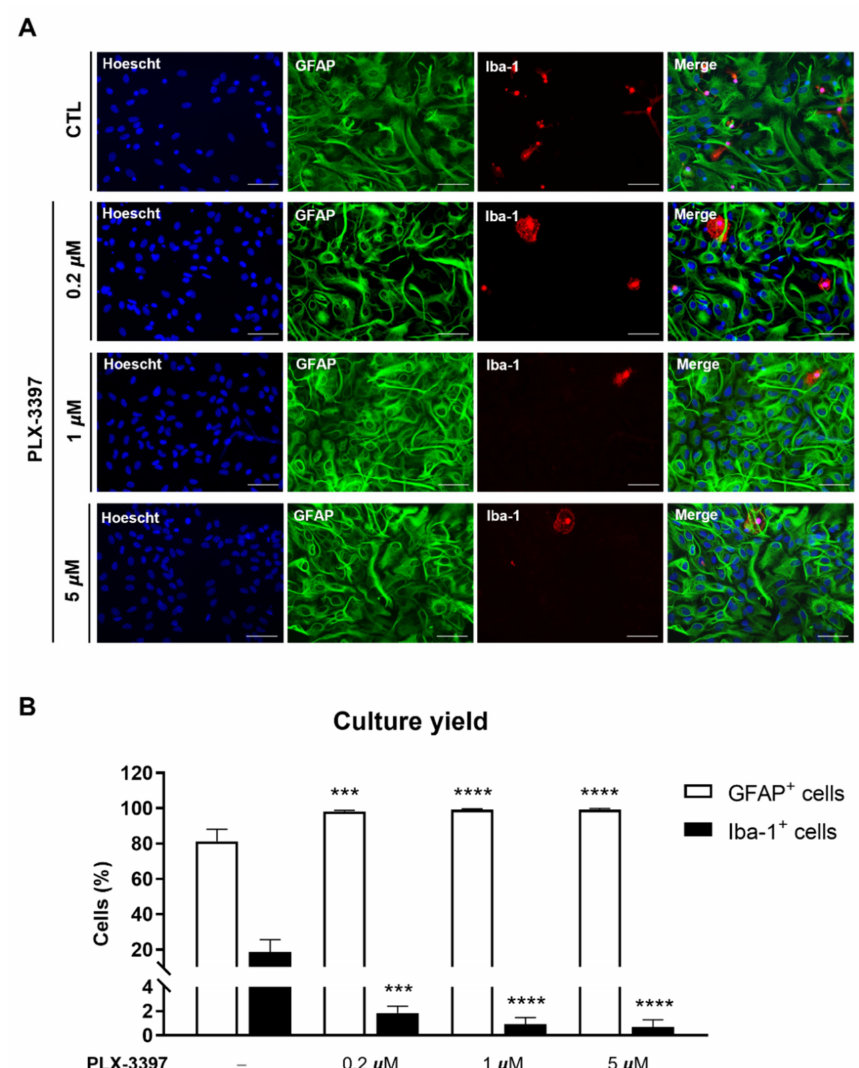
Figure 3. PLX-3397 significantly enhances culture yield. ( A ) Representative images of astrocytes and microglia in primary cultures of astrocytes with no exposure (CTL, − ) and exposure to 0.2 µ m, 1 µ m and 5 µ M of PLX-3397. GFAP-positive astrocytes are shown in green; microglia were identified with Iba-1 (red), and nuclei were counterstained with Hoechst (blue). Fluorescence images were acquired with a 40x objective in Zeiss Axiovert 200. Scale bar, 50 µ m. ( B ) Cell count was performed in ImageJ software. All values are mean ± SEM. N ≈ 4500 cells per condition from 4 independent